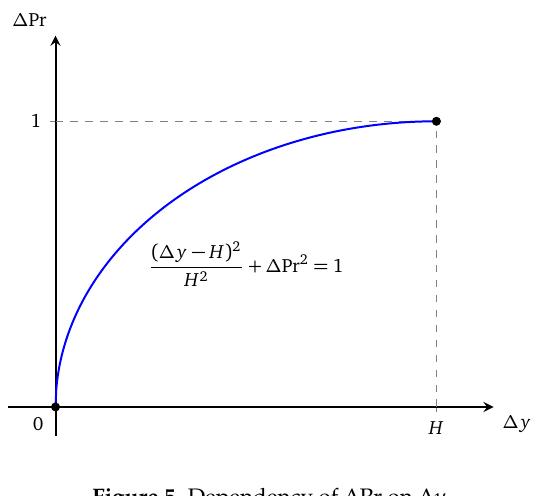
Figure 5. Dependency of ∆ Pr on ∆ y